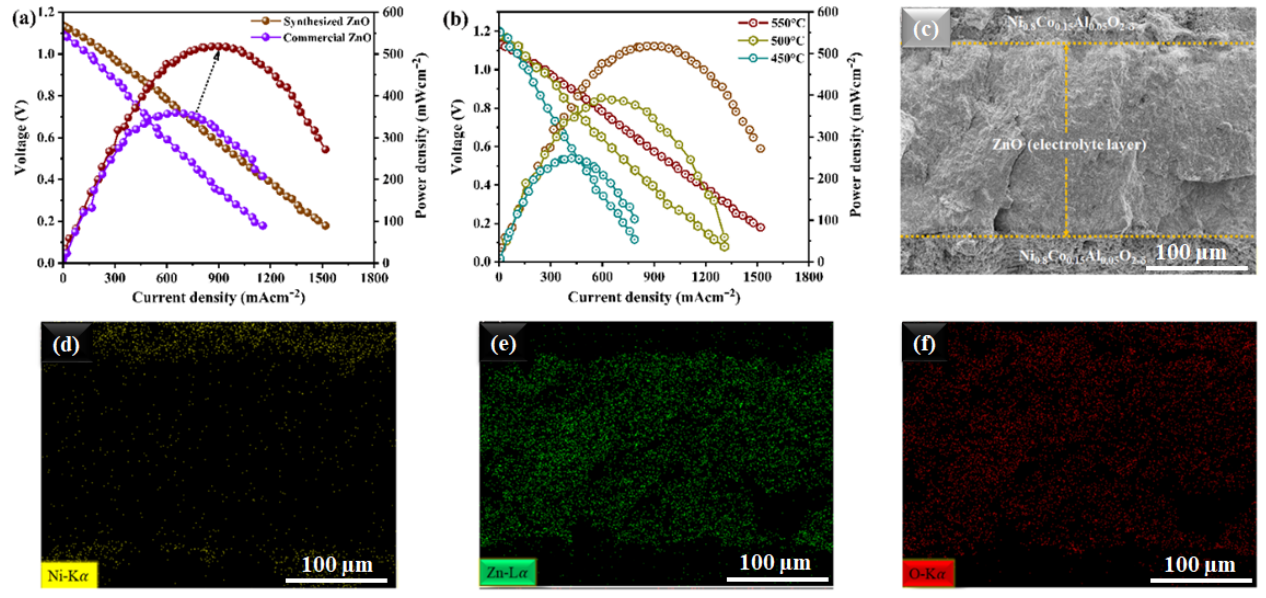
Figure 4. Characterization of the electrochemical performances: ( a ) characteristics curves of the typical current-voltage utilizing our ZnO nanoparticles and commercially purchased ZnO nanoparticles as electrolytes in fuel cells operated at 550 °C; ( b ) fuel cell performances using our prepared ZnO as an electrolyte under different operating temperatures of 450 − 550 °C; ( c ) cross-sectional SEM images of a tri-layer electrolyte-supported symmetrical fuel cell along with the prepared ZnO electrolyte examined after the electrochemical test; ( d – f ) EDS mapping of the ZnO electrolyte and Ni contents in the NCAL electrode.